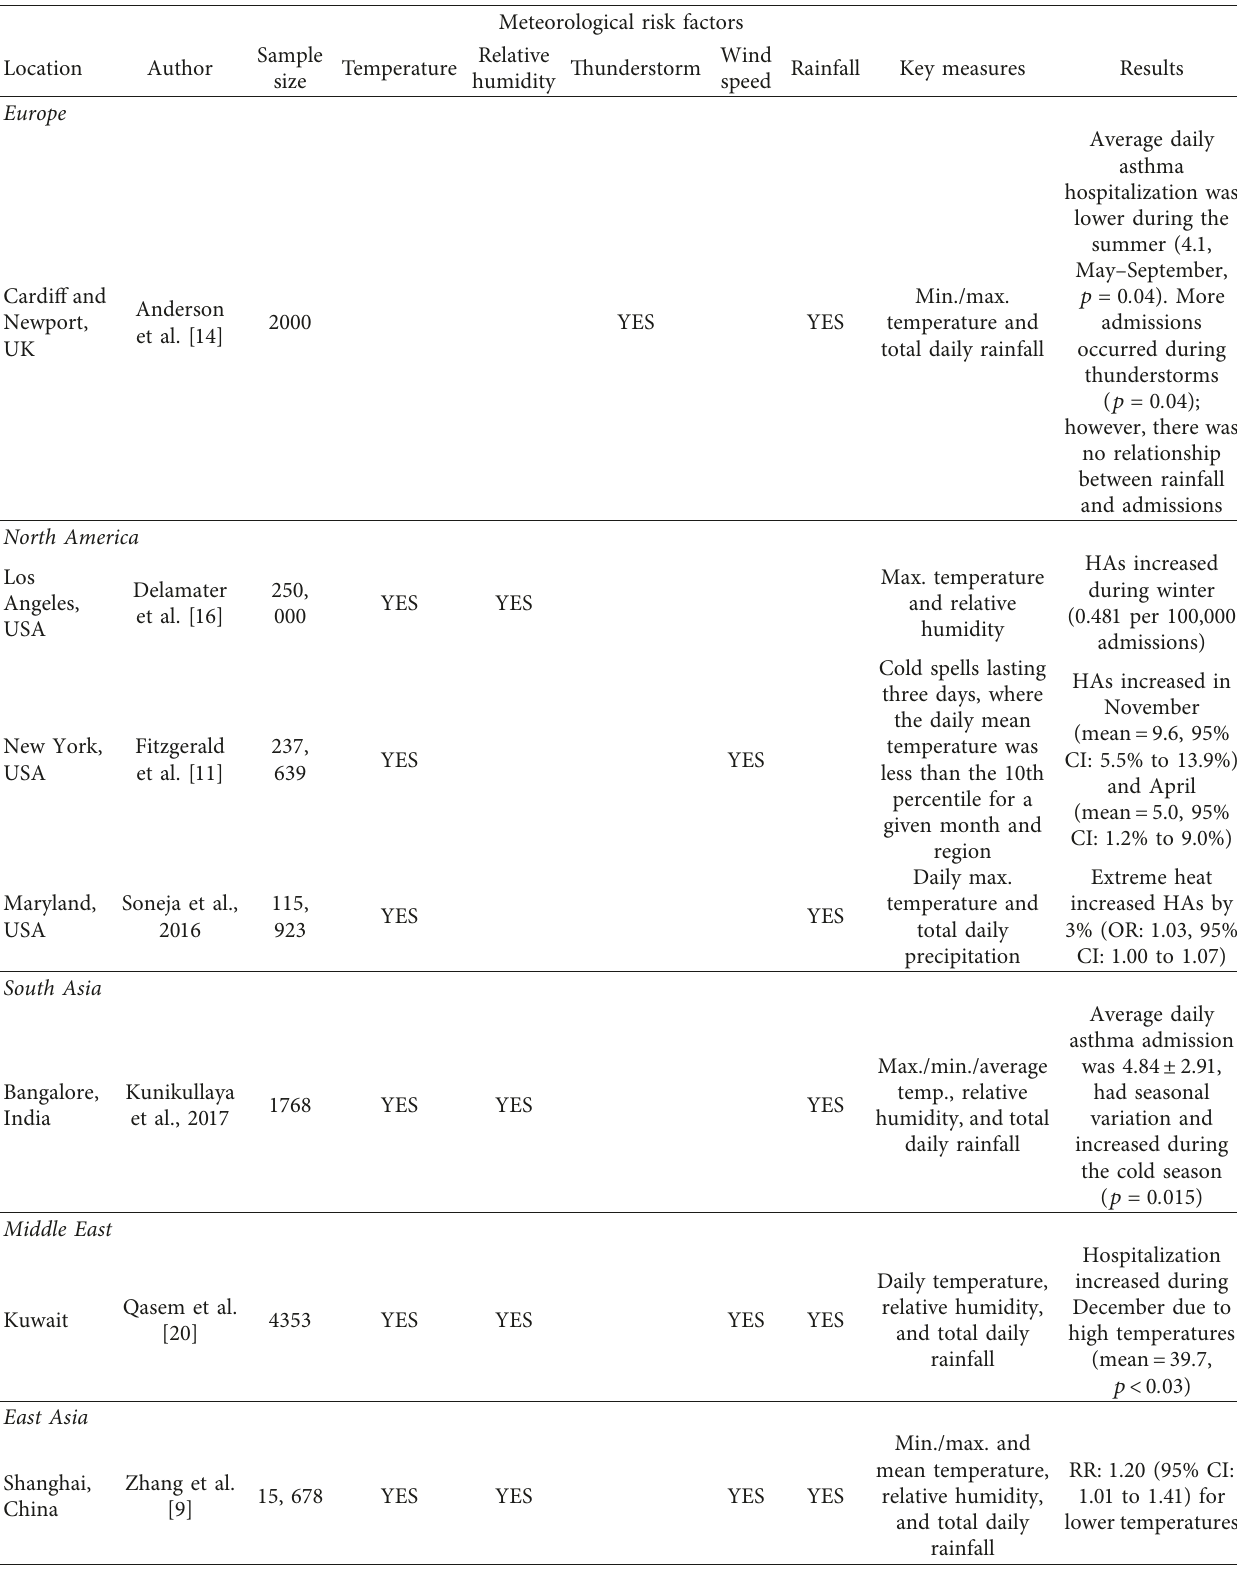
Table 4: Studies that examine the effect of meteorological factors on